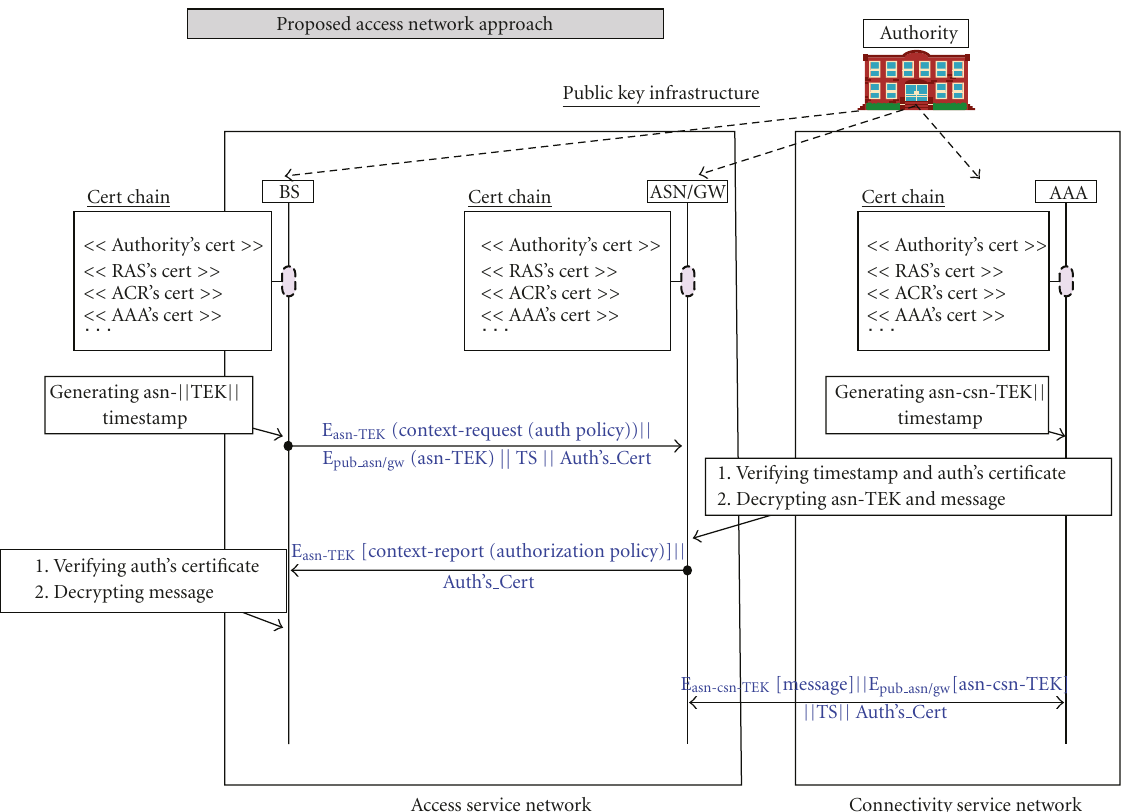
Figure 5: Proposed access network